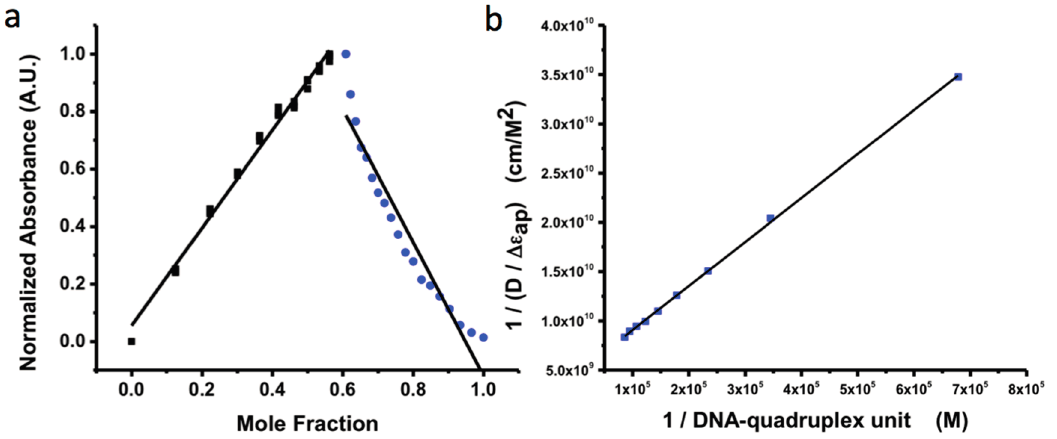
Figure 3. Affinity of PtTPFPP in DNA quadruplexes. ( a ) Job plot of the binding ratio (1:1) estimates 1 binding site for PtTPFPP (blue) per quadruplex unit (black); ( b ) The binding affinity of PtTPFPP and quadruplex was found to be K = 9.69